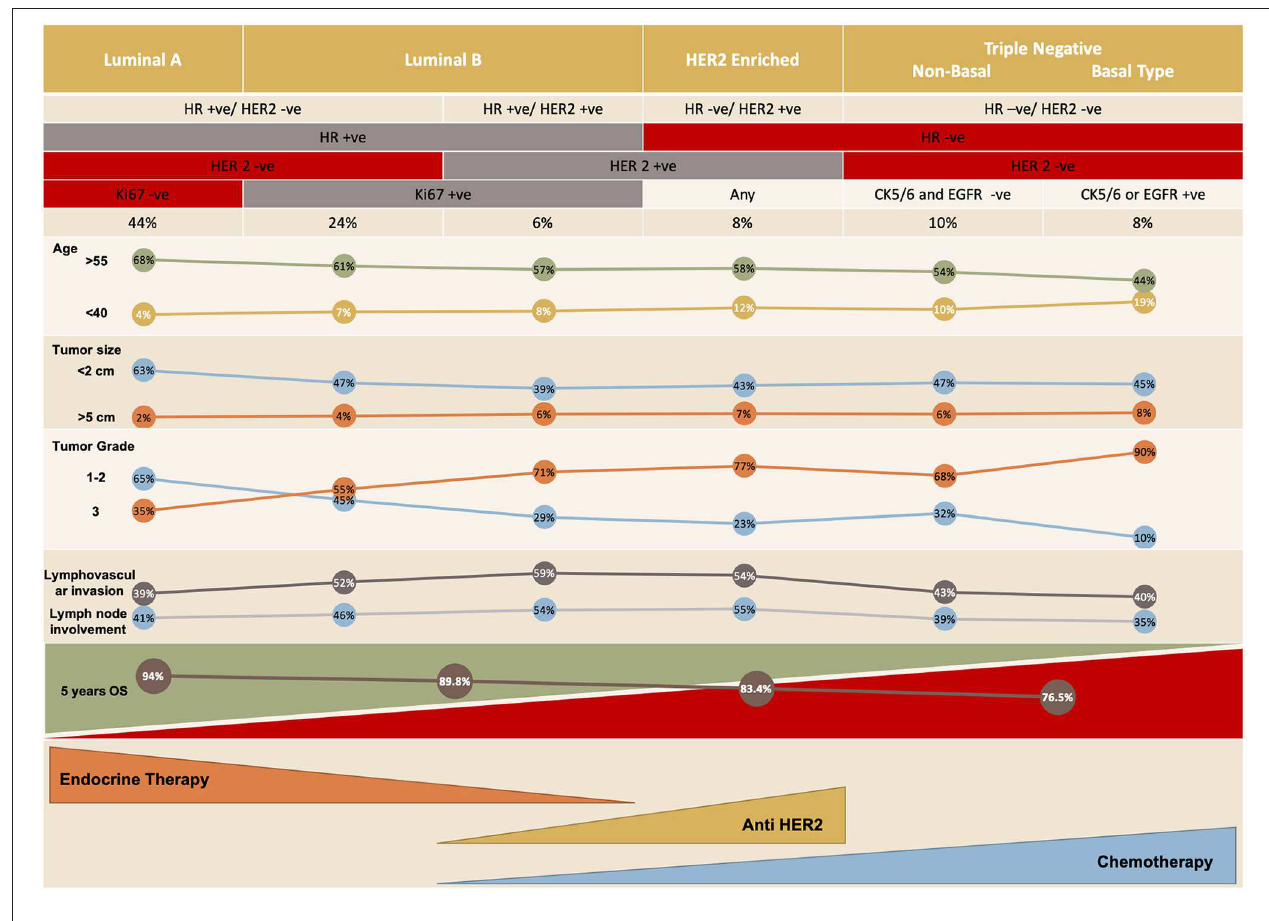
FIGURE 1 | Breast cancer molecular subtypes (4,